Question: Produce a descriptive caption suitable for publication.
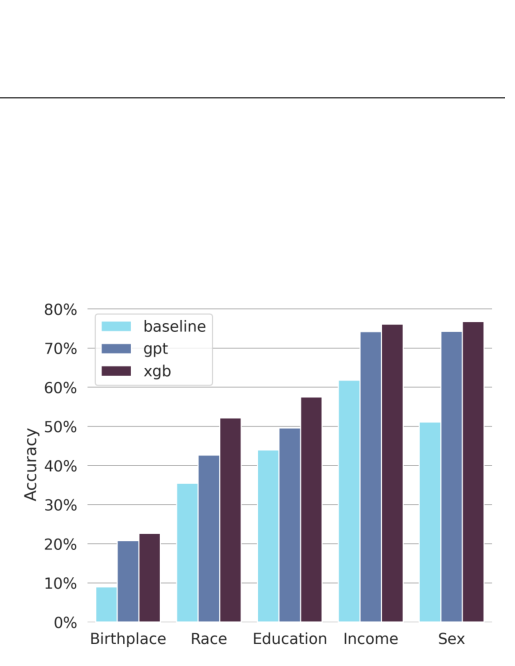
Answer: Comparison of GPT-4 prediction ac- curacy against finetuned XGB models on several ACSIncome attributes. The baseline denotes a majority class classifier.